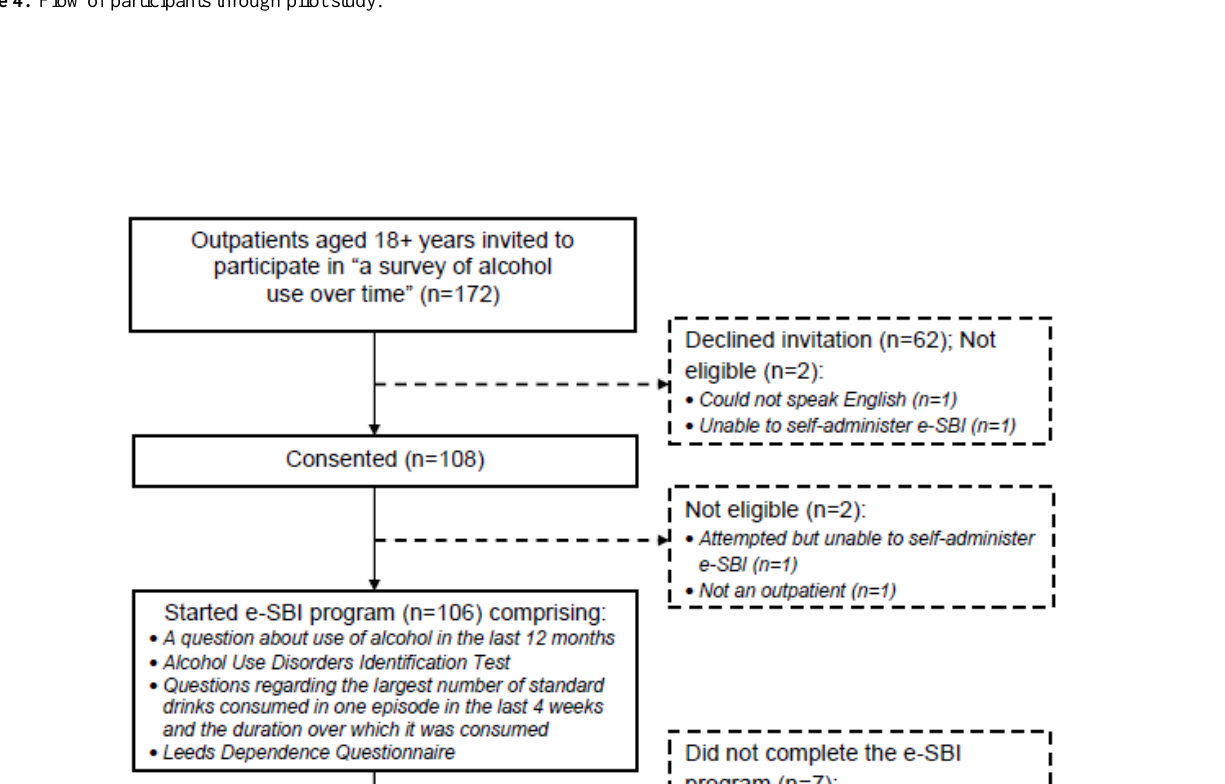
Figure 4. Flow of participants through pilot